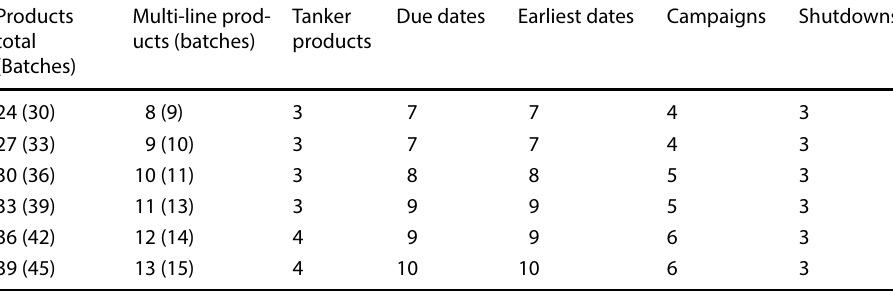
Table 4 Model input data for testing